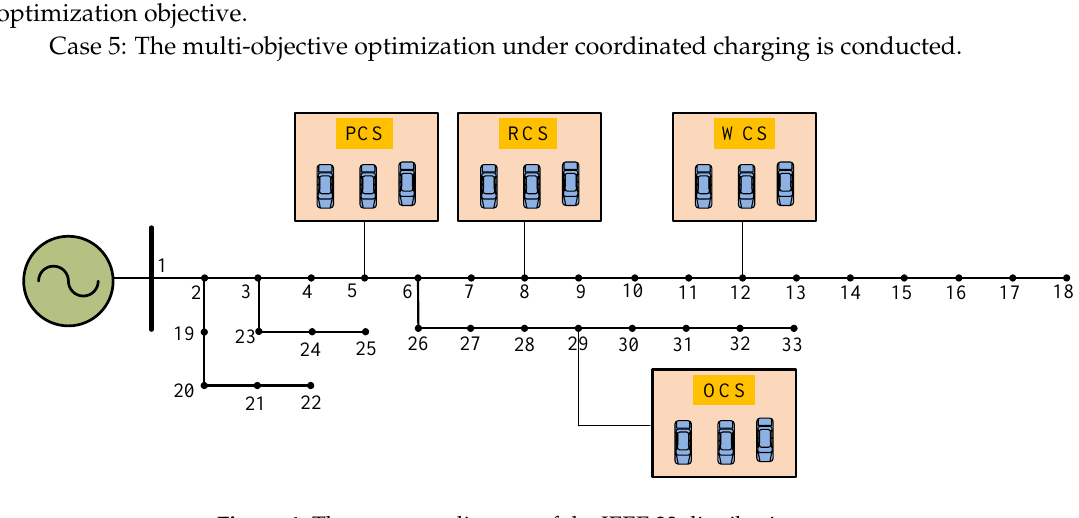
Figure 4. The structure diagram of the IEEE 33 distribution system. Table 3. Parameters of the simulation .